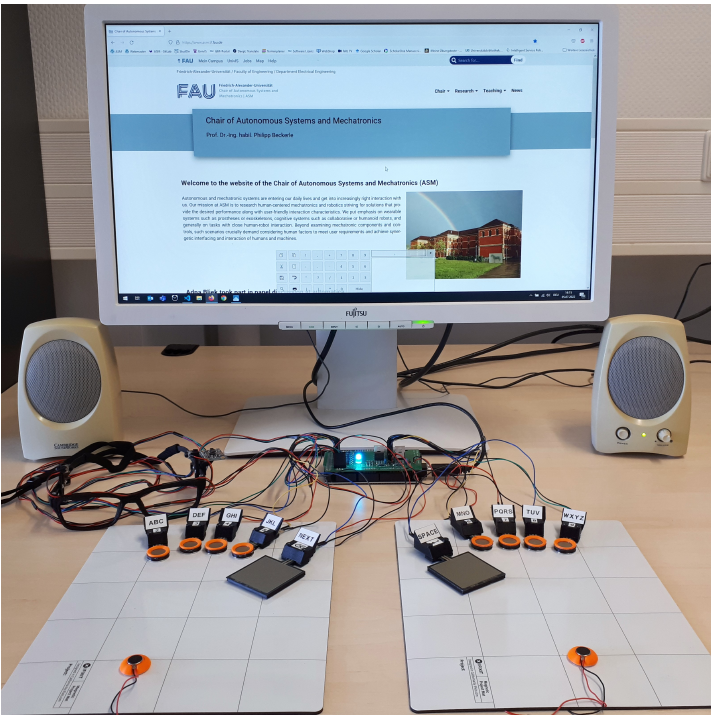
Figure 2. Image of the implemented alternative mouse and keyboard interface. The desktop appli- cation installed to be able to use the system for daily life tasks is active and creates a user interface in the lower center of the screen, with an opacity of 80%. The speakers on each side of the monitor are used to provide auditory feedback during the experiment and to introduce the user to each task through a brief instructional video. The 24” monitor has a screen resolution of 1920 × 1080